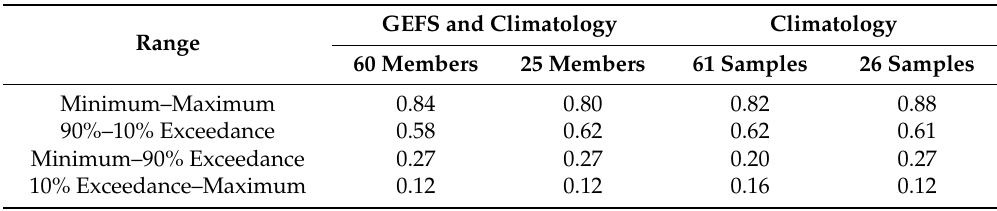
Table 3. Median containing ratios of different forecasts (1 October–1 May) of different scenarios for